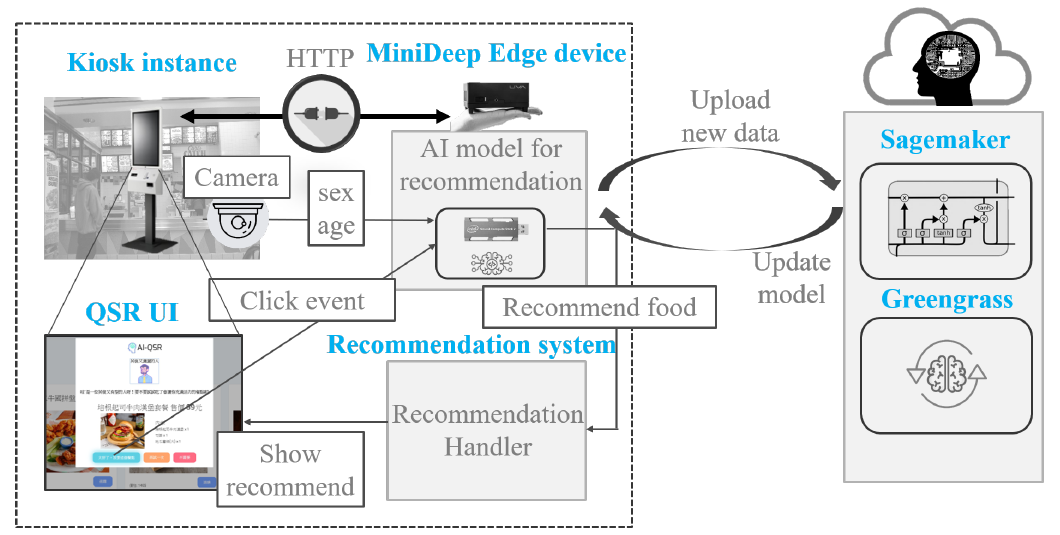
Figure 9. The AI-QSR system